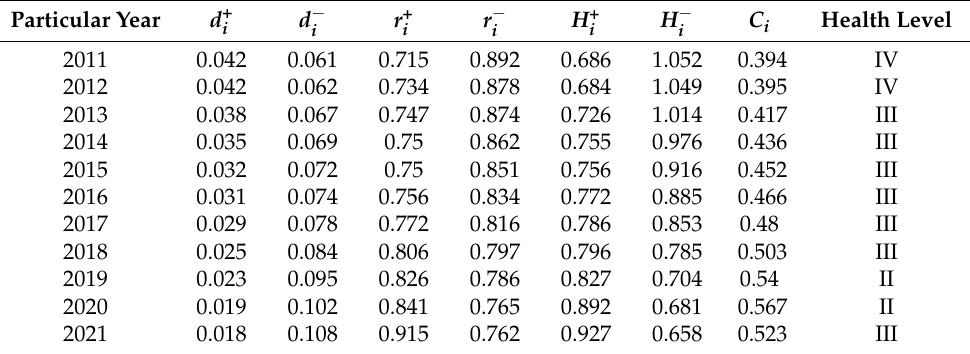
Table 5. C i calculation results of Zhengzhou relative patch